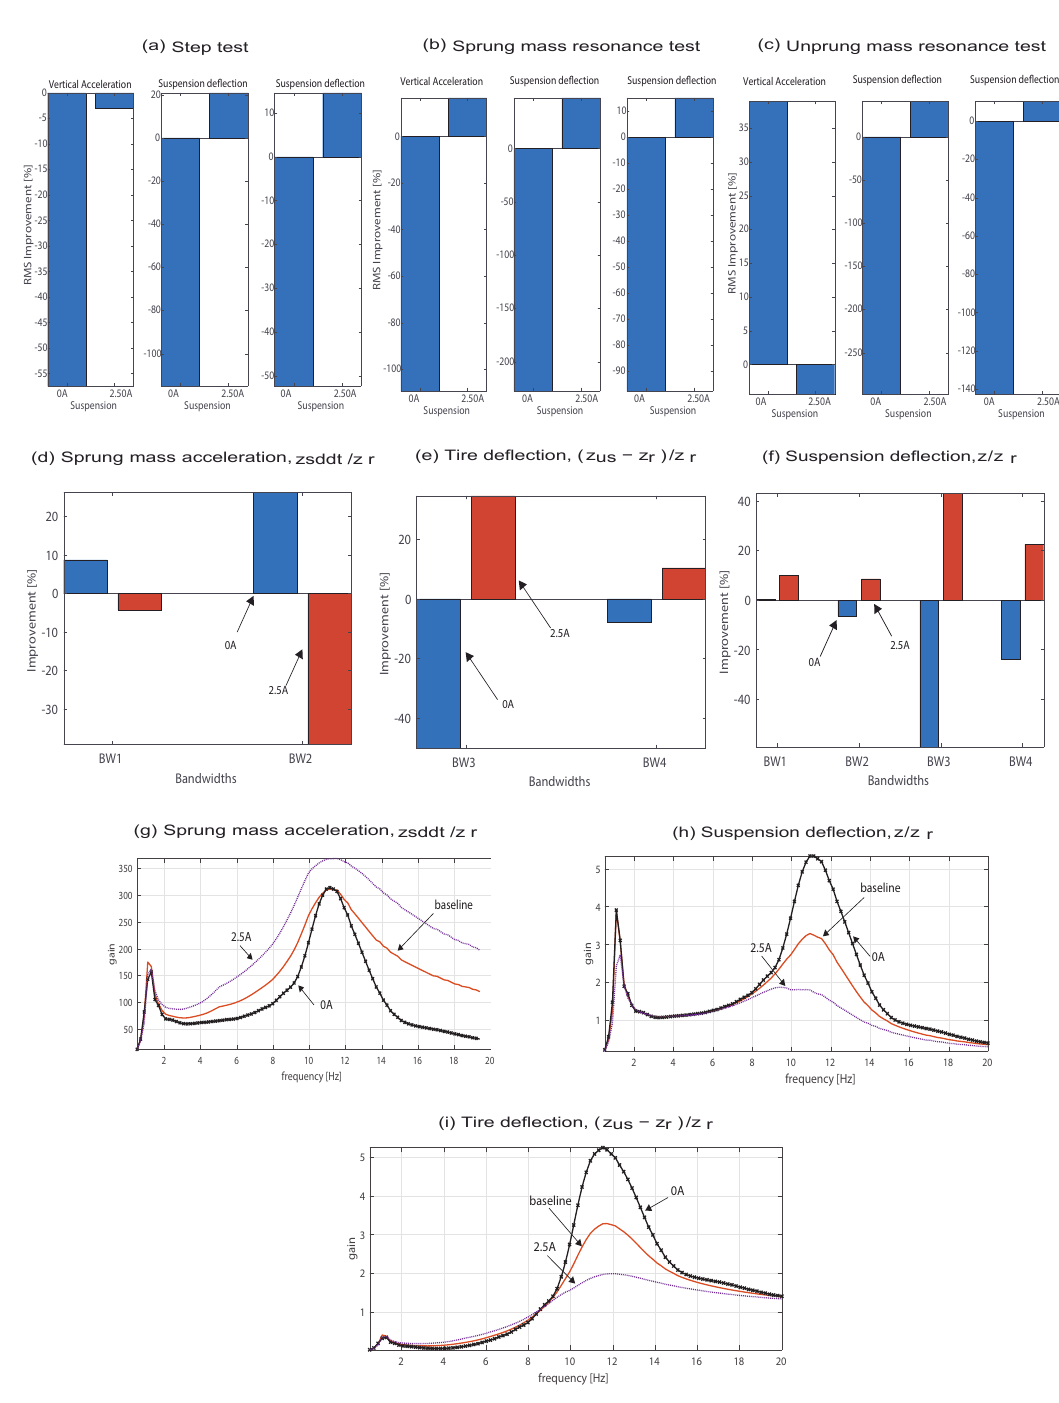
Figure 13. Results from open loop simulations for the comparison in a nonlinear QoV model considering a 1.25 A baseline